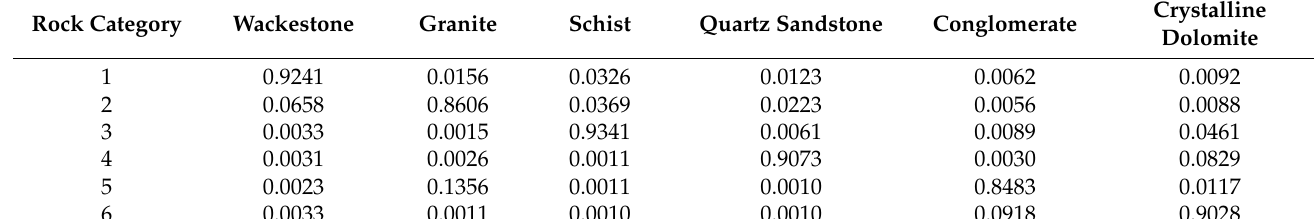
Table 4. Identification probability of rock images in Figure 14, the meaning of digits: 1- wackestone, 2-granite; 3-schist, 4-quartz sandstone, 5-conglomerate, 6-crystalline dolomite.